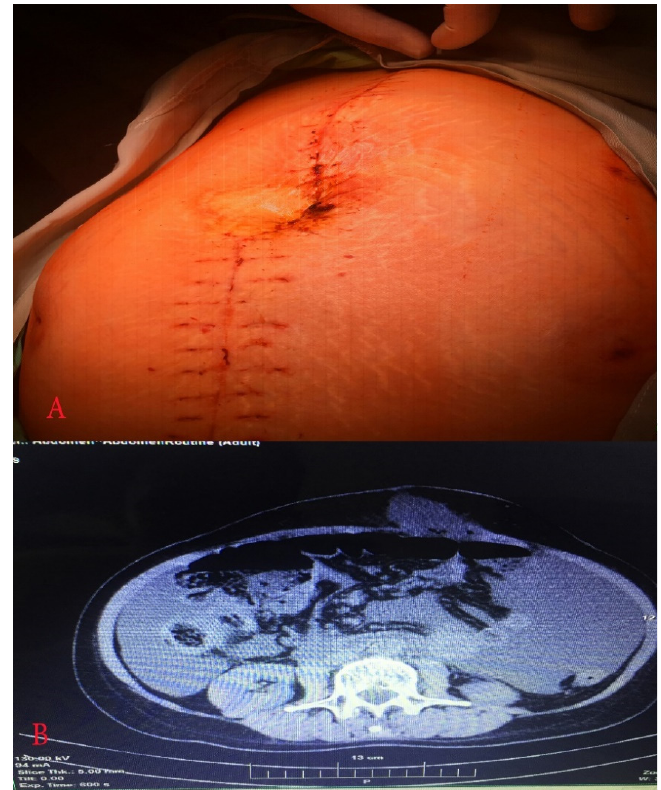
Figure 5. ( A ) Abdomen just before relaparotomy; ( B ) computed tomography showed postoperative ileus and elevated amount of free fluid.